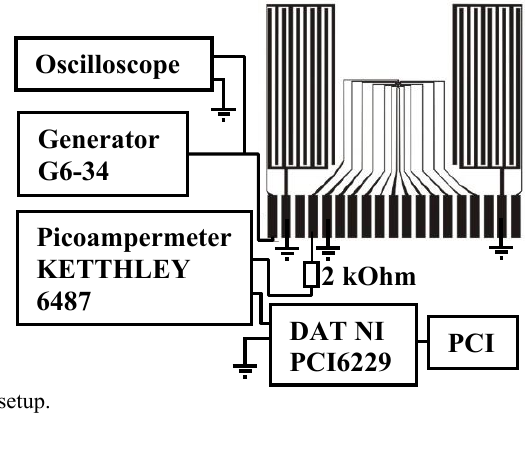
Fig. 4. Experimental